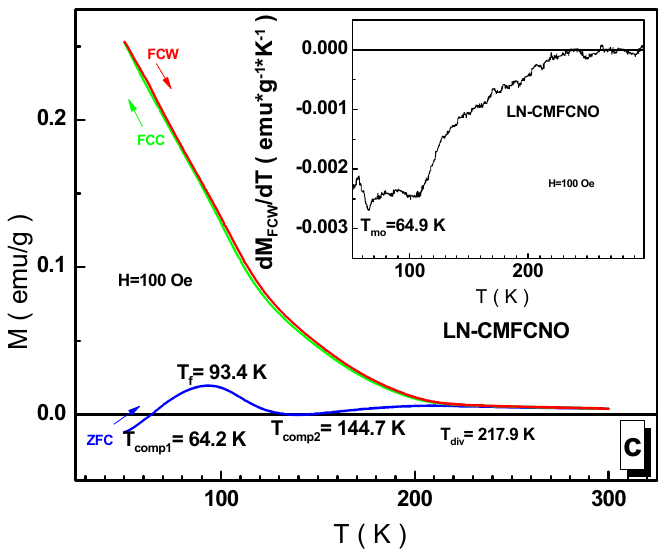
Figure 9. Temperature dependences of the specific magnetization in Zero-Field-Cooling and Field- Cooling regimes (FC-ZFC) for the La-CMFCNO ( a ), Nd-CMFCNO ( b ) and LN-CMFCNO ( c ) samples at 100 Oe. Insert demonstrates the temperature derivative of the corresponding FC curve.